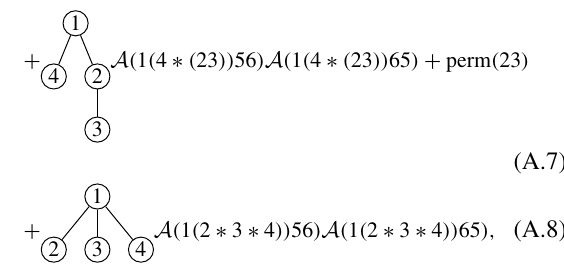
Fig. 4 The triangular prisms represent one T ( 1 , 2